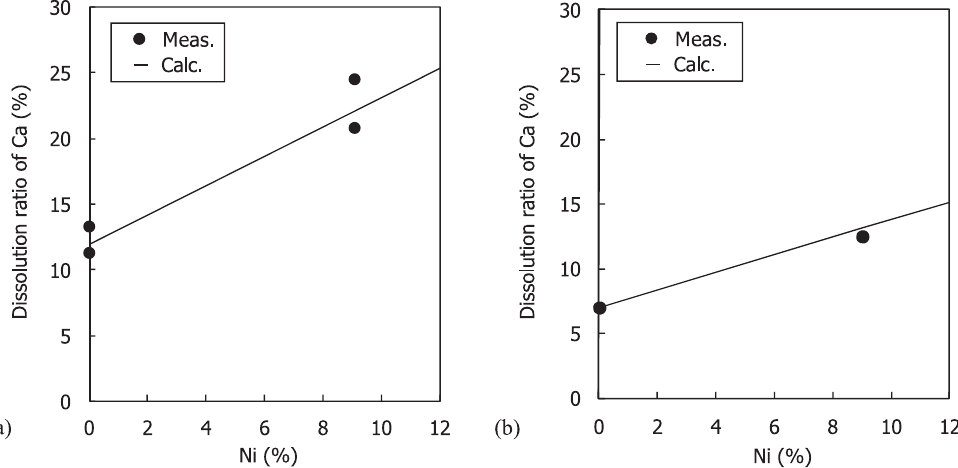
Fig. 7: Dissolution ratios of calcium in molten steel: laboratory-scale experiments (a) and plant tests (b). The calculated lines were obtained * = 1.35 atm and 0.68 atm in (a) and (b), respectively. using Eq. (7) and the assumption that P Ca